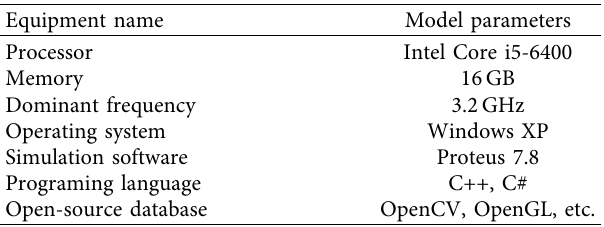
Table 1: Experimental software and hardware parameter configuration.